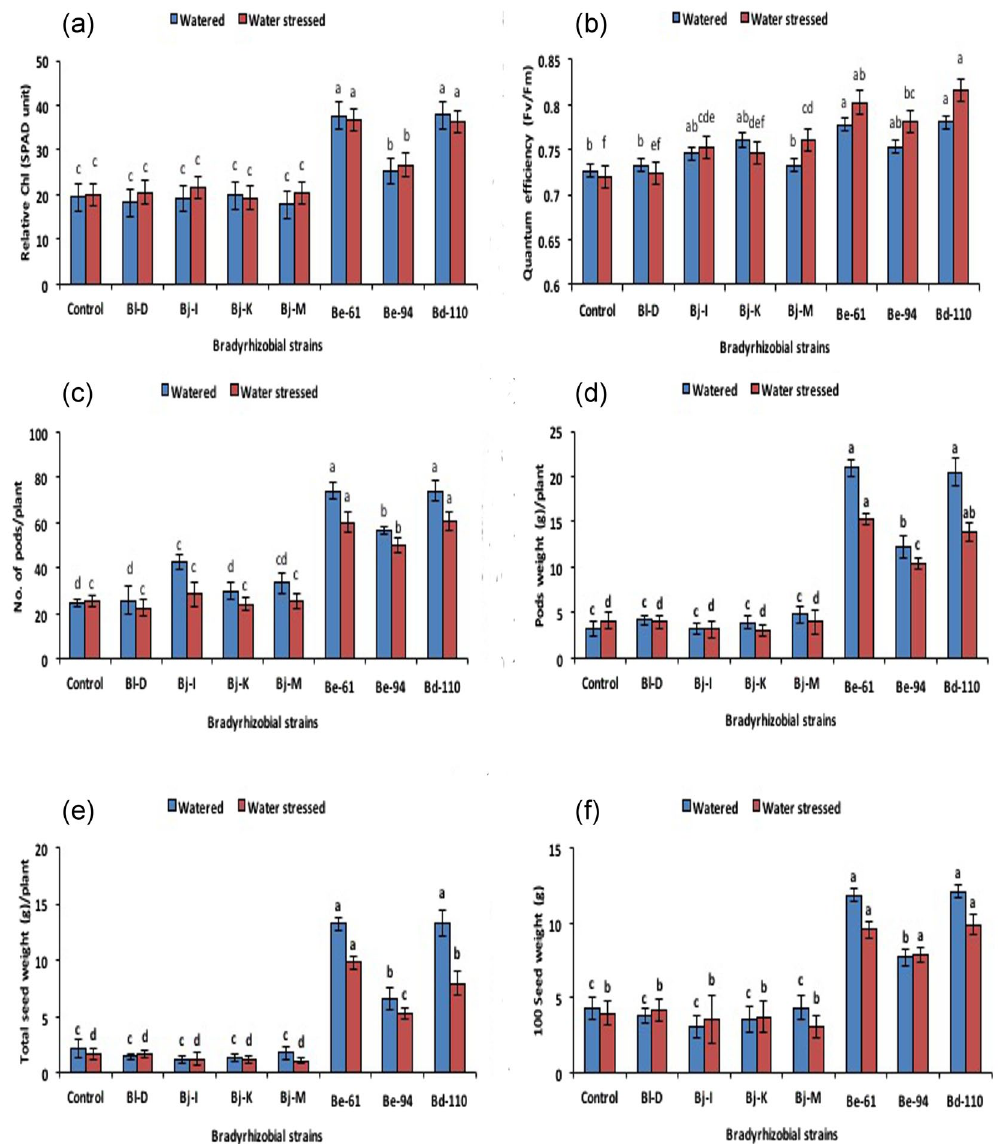
Figure 3. Inoculation effect of Rtx and non-Rtx bradyrhizobial strains on SPAD relative chlorophyll content ( a ), the quantum efficiency of PSII ( b ), number of pods ( c ), pot weight ( d ), total seed yield ( e ) and test seed weight ( f ) in soybean plants under watered and water-stressed